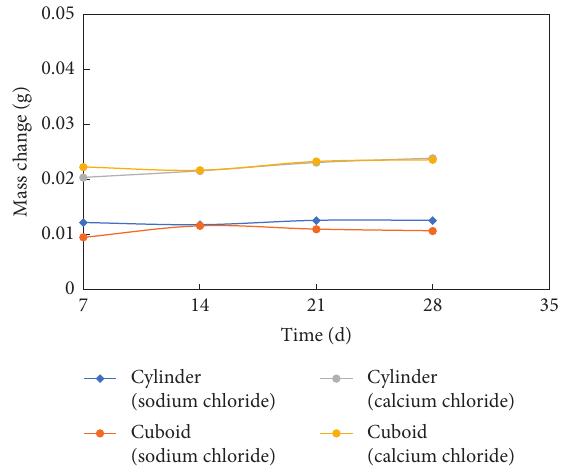
Figure 13: Mass change of HWC materials eroded by solution.